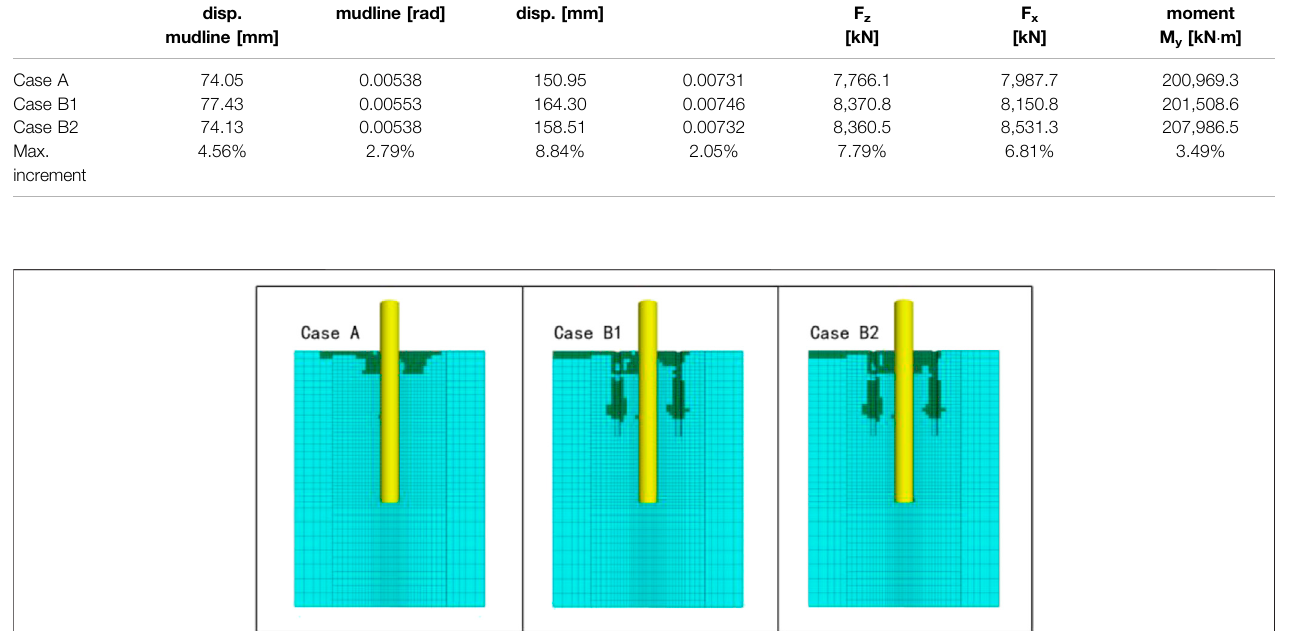
FIGURE 11 | The plastic zone under different